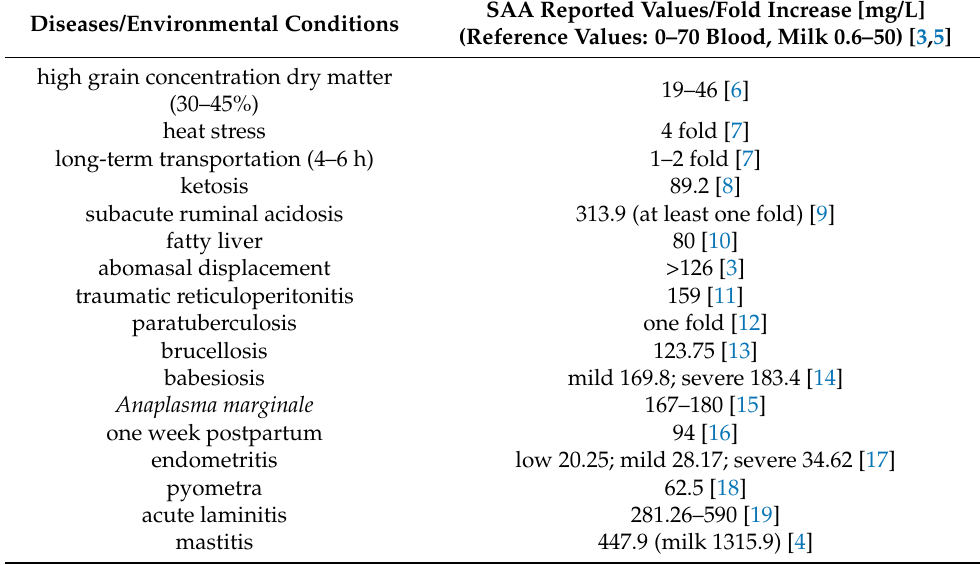
Table 1. Examples of diseases/environmental conditions upregulating SAA blood concentration in adult cattle.